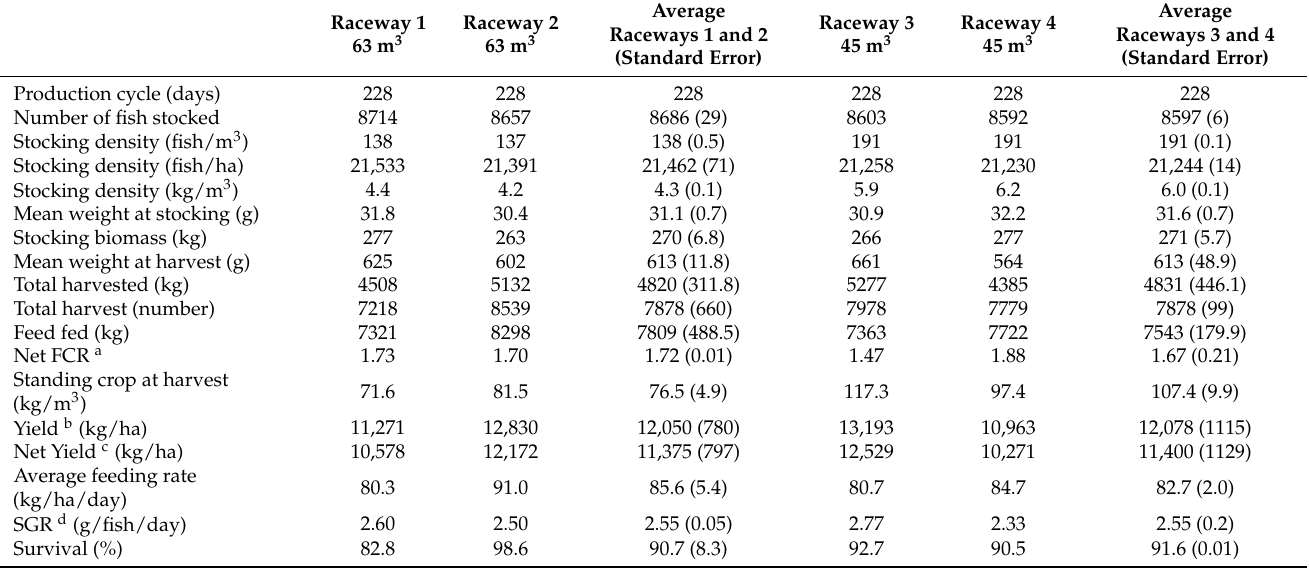
Table 4. Growout growth performance of hybrid catfish (channel catfish Ictalurus punctatus catfish, I. furcatus ) raised in in-pond raceway system (IPRS) raceways placed in 0.4 ha ponds, ♂